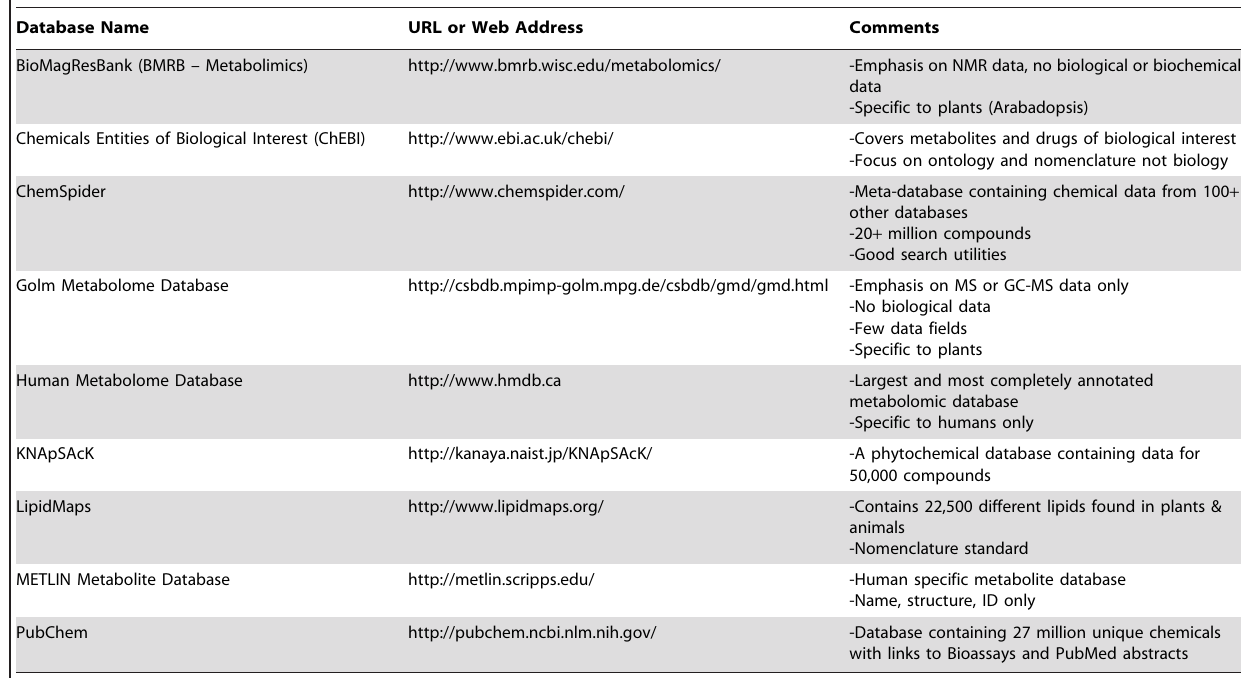
Table 2. Alphabetical List of Metabolomic, Chemical or Spectral Databases.